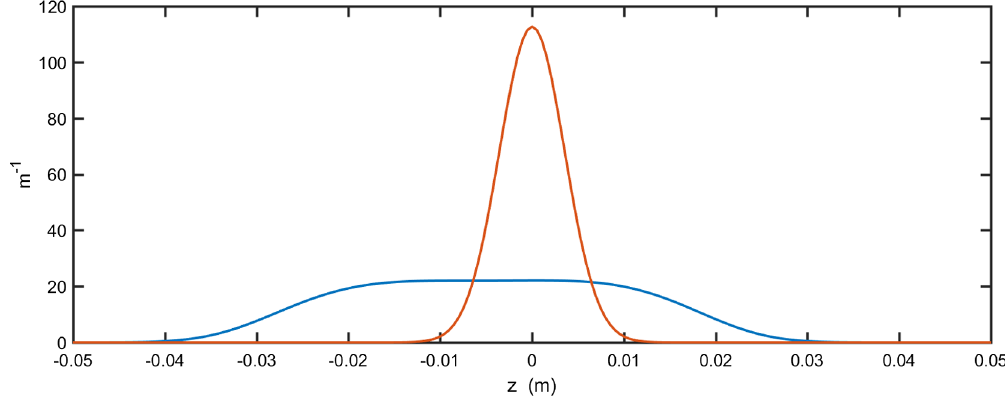
3. Charge density for complete fill at 500 mA (blue curve), with rms width σ ¼ 4 . 08 σ solution at a low current (red curve) with σ